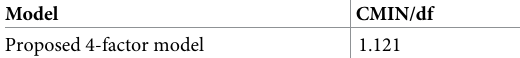
Table 2. Confirmatory factor analysis. Model